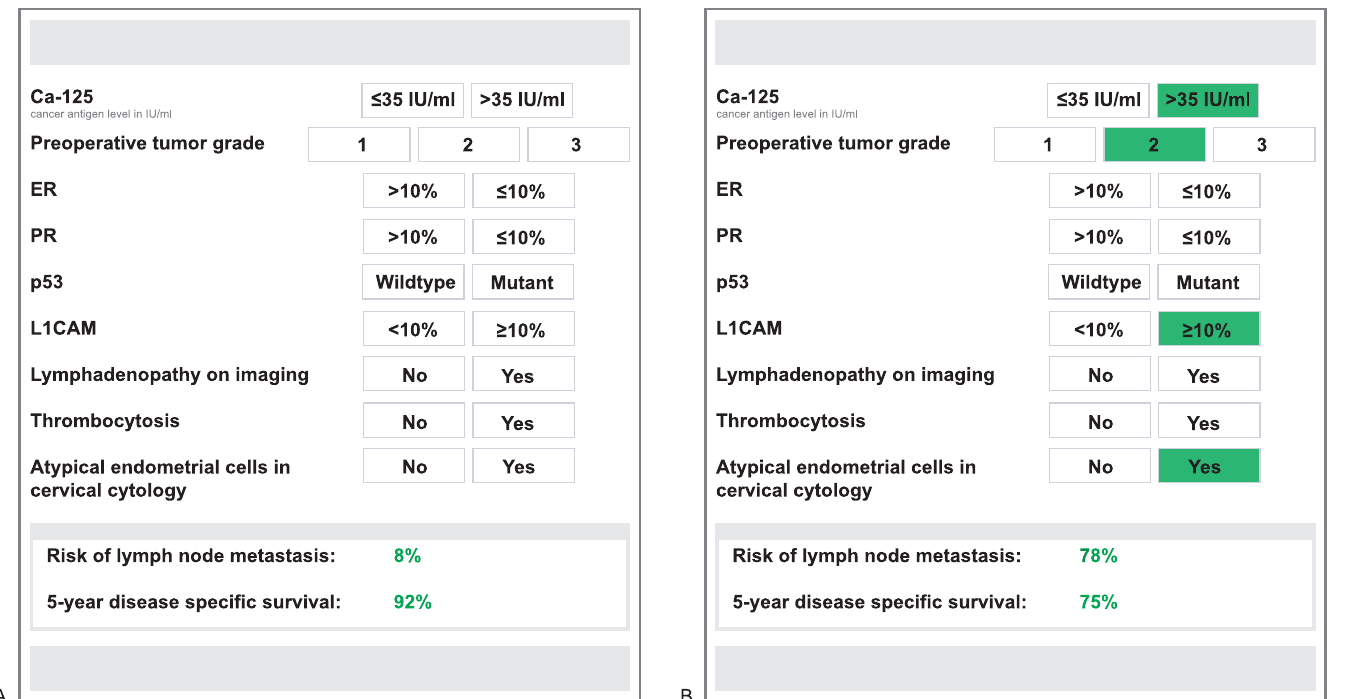
Fig 3. Concept web-based interface of the BN. The baseline probability estimates for LNM and 5-year DSS (visualized in panel A) are interactively updated when variables are provided to the model (visualized in panel B). BN, Bayesian network; Ca-125; cancer antigen 125; DSS, disease-specific survival; ER, estrogen receptor; LNM, lymph node metastasis; L1CAM, L1 cell adhesion molecule; PR, progesterone receptor.